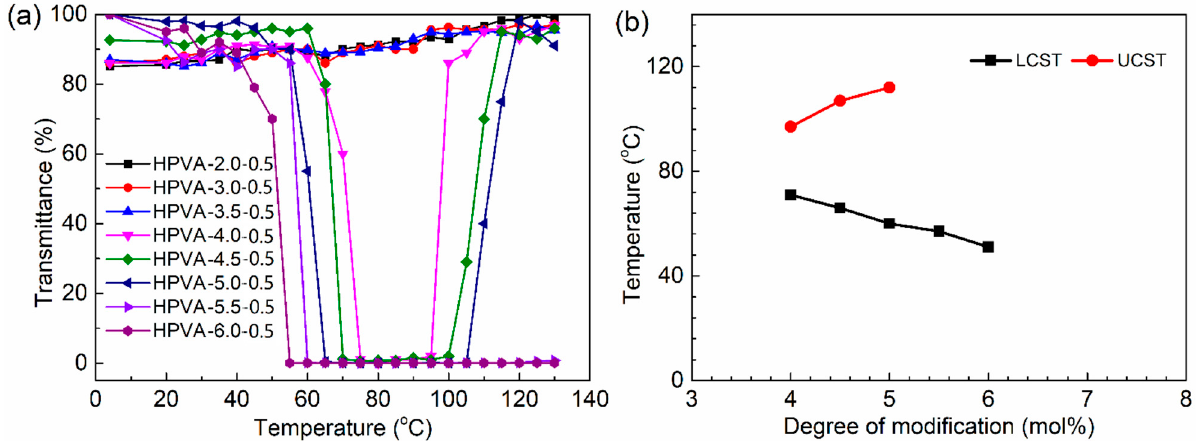
Figure 6. ( a ) Temperature dependence of the optical transmittance for aqueous solutions of HPVA for different degree of hydrophobic modification. Changes in transmittance were recorded during heating at 10 ◦ C/h. ( b ) Variation in LCST and UCST as functions of degree of modification for HPVA in saline. The LCST and UCST were defined as a 50% of maximum in transmittance in ( a ). The effect of crosslinking density of the hydrogels on the LCST and UCST behaviors was also investigated. In this vein, six CHPVA hydrogel samples with two different degrees of hydrophobic modification, i.e., 4.0 mol% and 5.0 mol%, were synthesized by varying the concentration of the crosslinker glutaraldehyde (0.5%, 1.0% and 1.5 wt.%). Figure 7 shows the plots of transmittance as a function of temperature for the hydrogels. It can be seen that for both CHPVA hydrogels with modification degree of 4.0 mol% and 5.0 mol%, the crosslinking density has a great effect on the thermosensitivity of the hydrogels. For the CHPVA hydrogels with the same modification degree, both the LCST and UCST increase with the increase in crosslinking density, indicating the increase in crosslinking density of CHPVA hydrogels require temperature increase to provide higher thermal energy to break the inter-/intra-molecular and polymer-water effect. In addition, the LCST of the chemically cross-linked hydrogels decreases whereas the UCST increases compared with the HPVA solution with the same degree of hydrophobic modi fi cation.